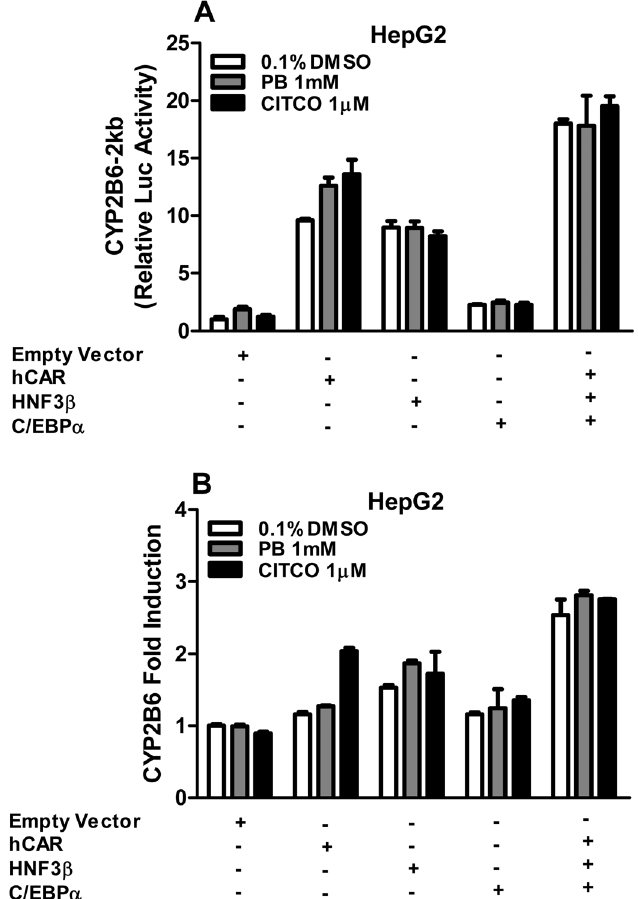
Fig 3. Effects of HNF3 β on hCAR-mediated CYP2B6 activation in HepG2 cells. HepG2 cells were co- transfected with expression plasmids of hCAR, HNF3 β or C/EBP α in the presence (A) or absence (B) of CYP2B6-2kb reporter construct as detailed in the Materials and Methods . Transfected cells were then treated with PB (1mM) and CITCO (1 μ M) for 24 h. Dual luciferase activities (A) and CYP2B6 mRNA expression (B) were detected and expressed relative to vehicle control by reporter assay and real-time PCR